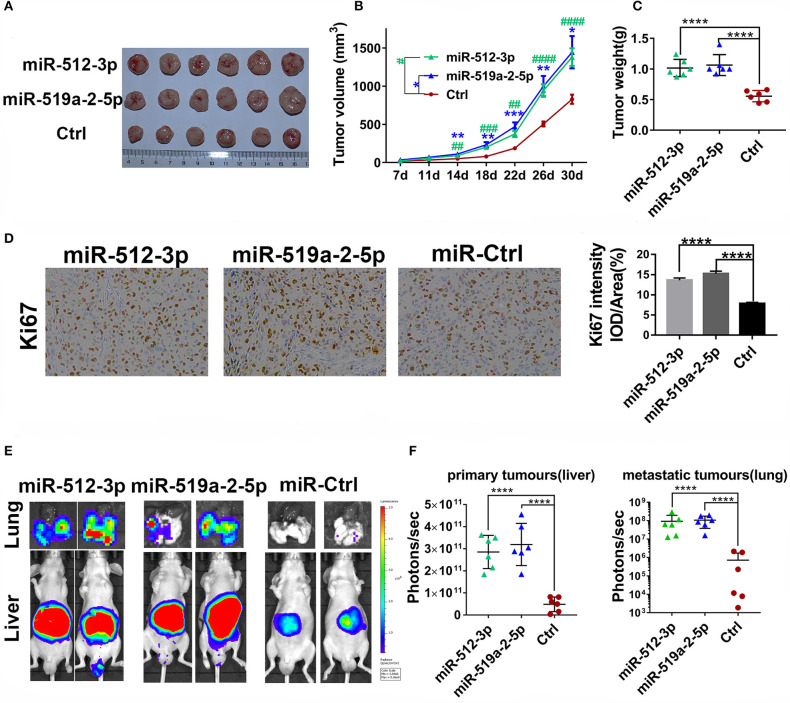
MiR-519a-2-5p and miR-512-3p promoted HCC metastasis and growth in vivo. (A–C) The efficiency of miR-512-3p and miR-519a-2-5p on the proliferation of HCC xenograft tumors. (A) The images of the xenograft tumors which were derived from miR-512-3p, miR-519a-2-5p, and the control-transfected LM3. (B) Tumor volume was measured. “*” represented the comparison between the miR-519a-2-5p group and the control group, “#” represented the comparison between the miR-512-3p group and the control group. (C) Tumor weight was measured on the day of 30. (D) The immunohistochemical staining of ki-67 from the tumors tissues derived from miR-519a-2-5p, miR-512-3p-transfected LM3, and their controls. (E,F) The efficiency of miR-512-3p and miR-519a-2-5p on the invasion and metastasis of HCC orthotopic mouse models. (E) Representative bioluminescence imaging of abdominal tumor burden and lung metastasis in all groups. (F) Quantification of bioluminescent signal intensity on the liver (primary tumors) and lungs (metastatic tumors). All error bars indicated the mean ± SD. The statistics analysis was performed with the one-way ANOVA test. “**”, “***” and “****” represented the p-value < 0.01, 0.001 and 0.0001, respectively. “##” “###” “###” represented the p-value < 0.01, 0.001 and 0.0001, respectively.